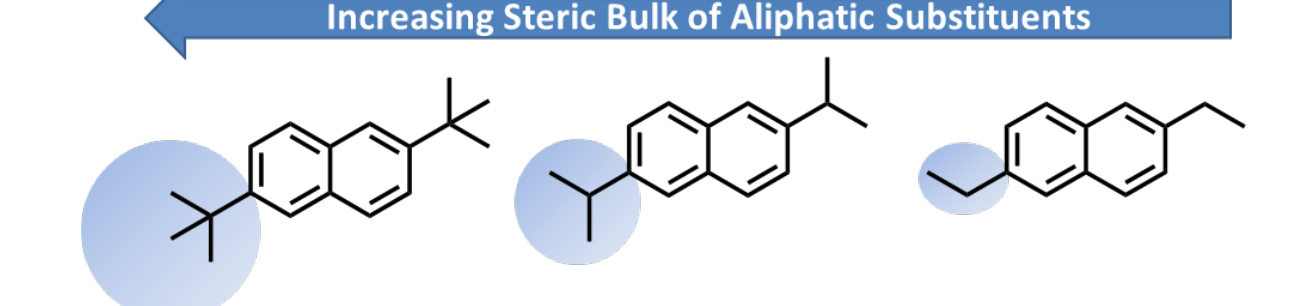
Figure 6. Molecular structures of naphthalene and naphthalene with various 2,9-alkyl substituents and increasing steric bulk. Illustrative steric volumes of pendent alkyl groups are shown in a shaded area. Shaded areas are not to scale. Tolman cone angles are: ethyl = 132°, isopropyl = 160°, and t-butyl = 182° [59].